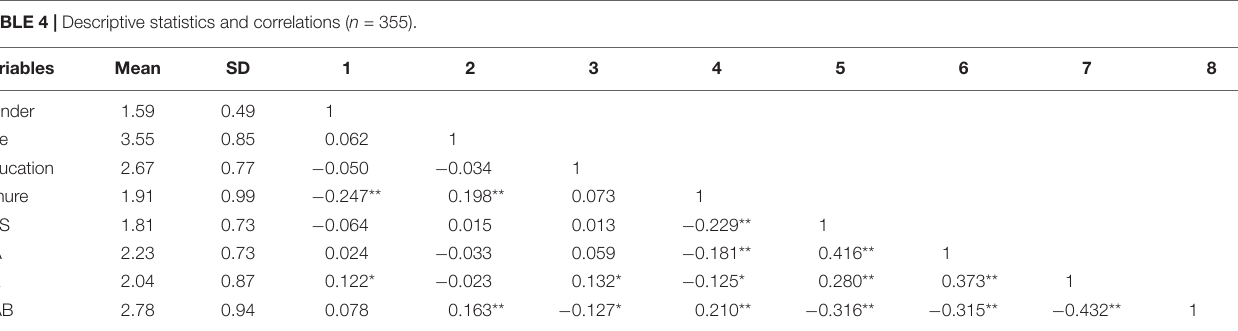
TABLE 4 | Descriptive statistics and correlations ( n = 355). Variables